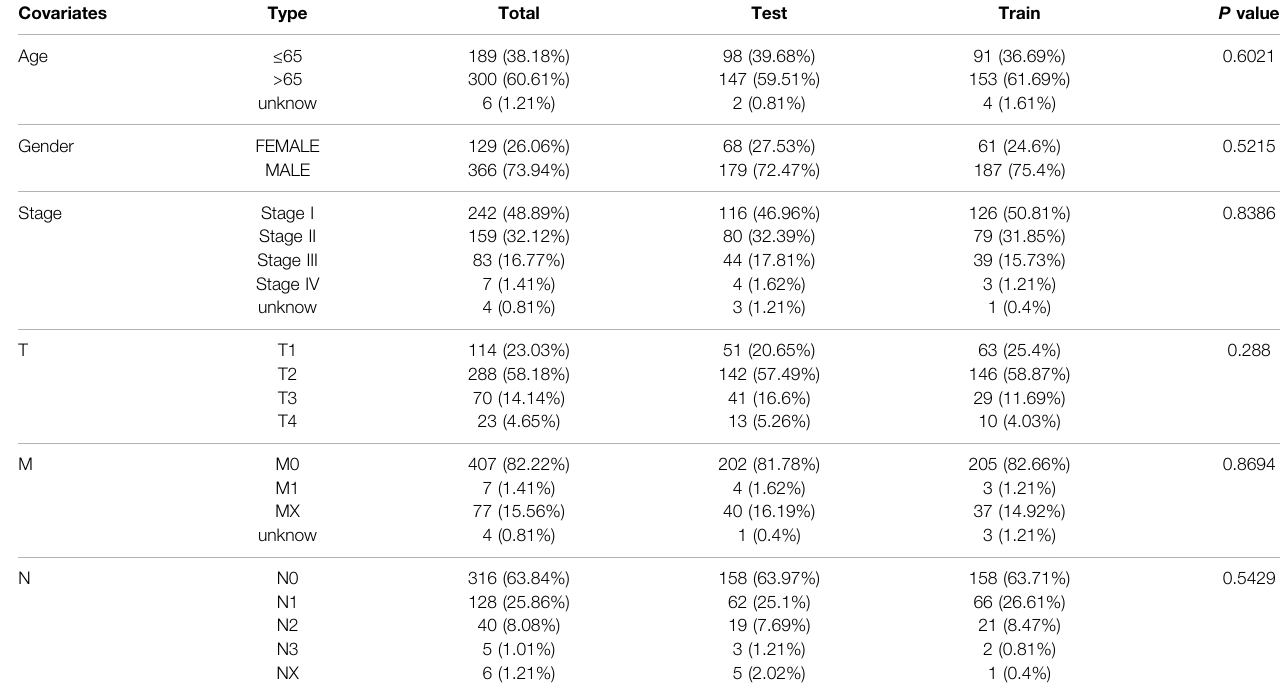
TABLE 2 | Clinicopathological characteristics of LUSC patients in training and test group.